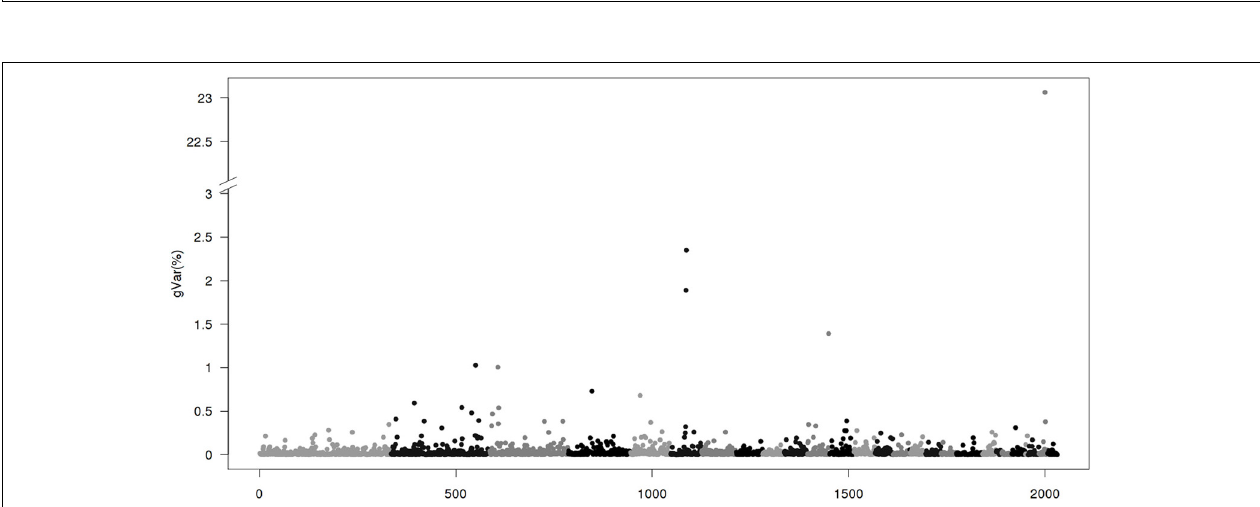
FIGURE 3 | Proportion of genetic variance of 20-SNP region using classical genome wide association studies (CGWAS) implemented by WOMBAT. The x-axis represents region location of 20 SNPs. The y-axis represents the proportion of genetic variance of each region.